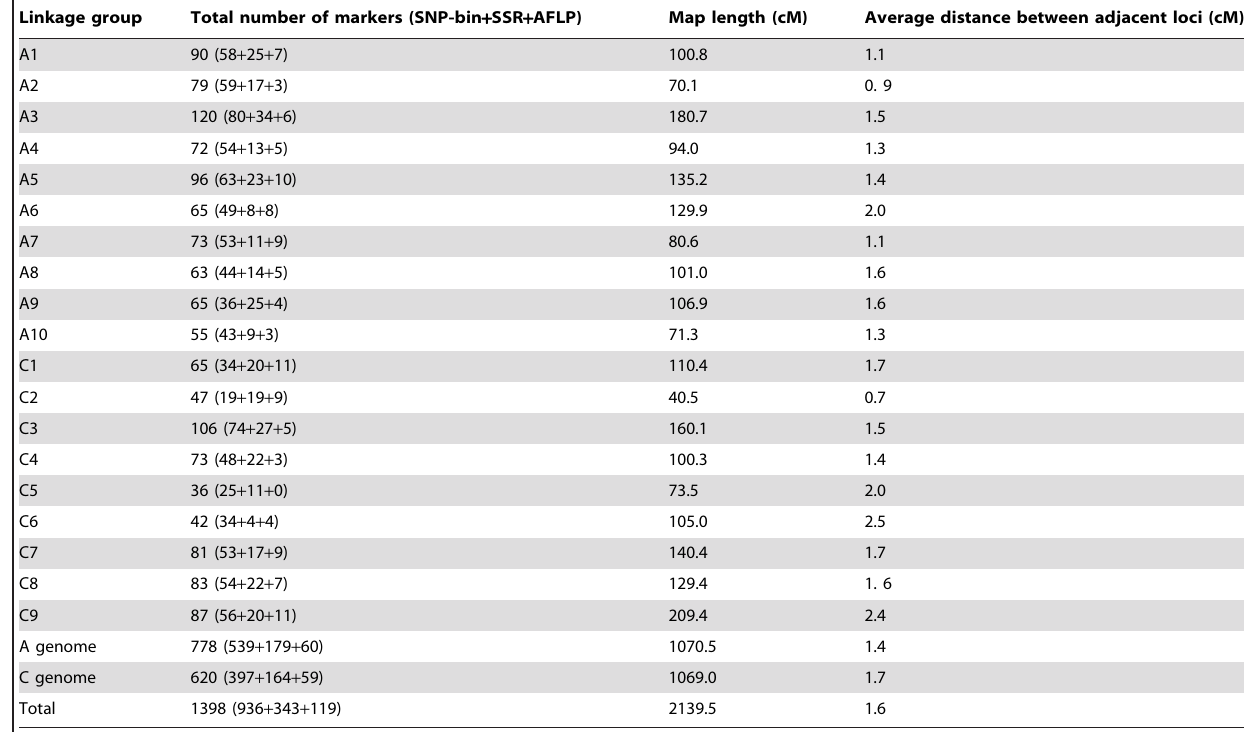
Table 1. Summary of the total number of markers, map length and average distance between adjacent loci of the Brassica napus high-density linkage map based on the QW DH population derived from a cross between the B-efficient parent Qingyou 10 and the B-inefficient parent Westar